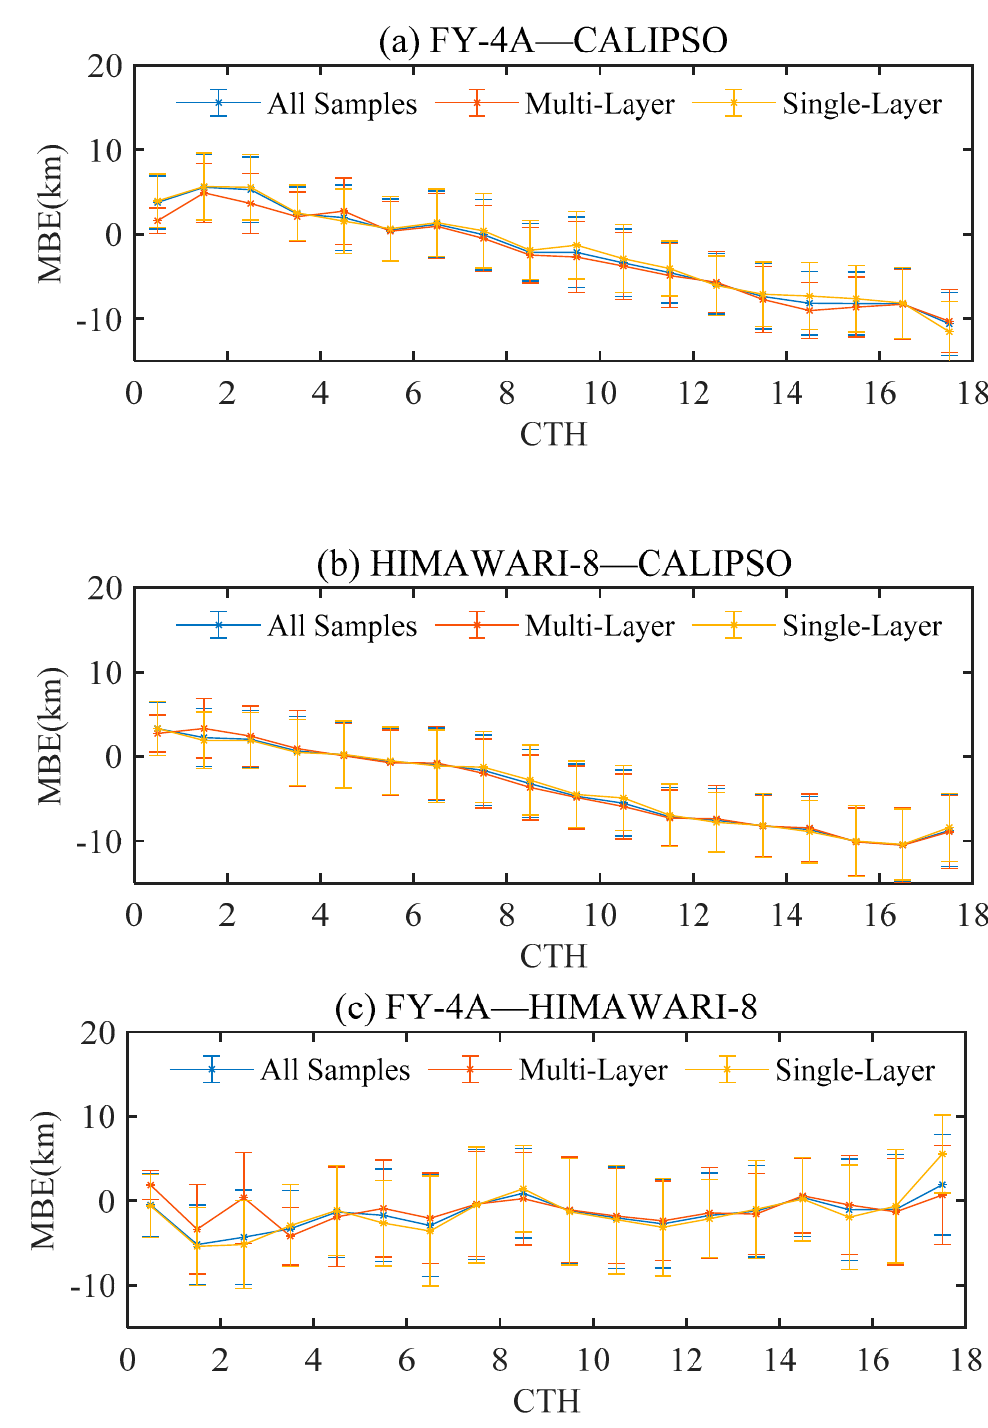
Figure 4. The variation of MBE with CTH for all samples, multi-layer clouds and single-layer clouds of different satellites. The error bars represent STD. ( a ) FY-4A–CALIPSO ( b ) HIMAWARI-8–CALIPSO ( c ) FY-4A–HIMAWARI-8.